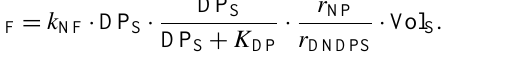
Figure A3. Stable carbon isotopic composition of atmospheric CO 2 . Model results vs. ice-core data (Schmitt et al., 2012). The model results were obtained in the standard simulation STD without any tuning of the 13 C-CO 2 fluxes across the seawater–atmosphere